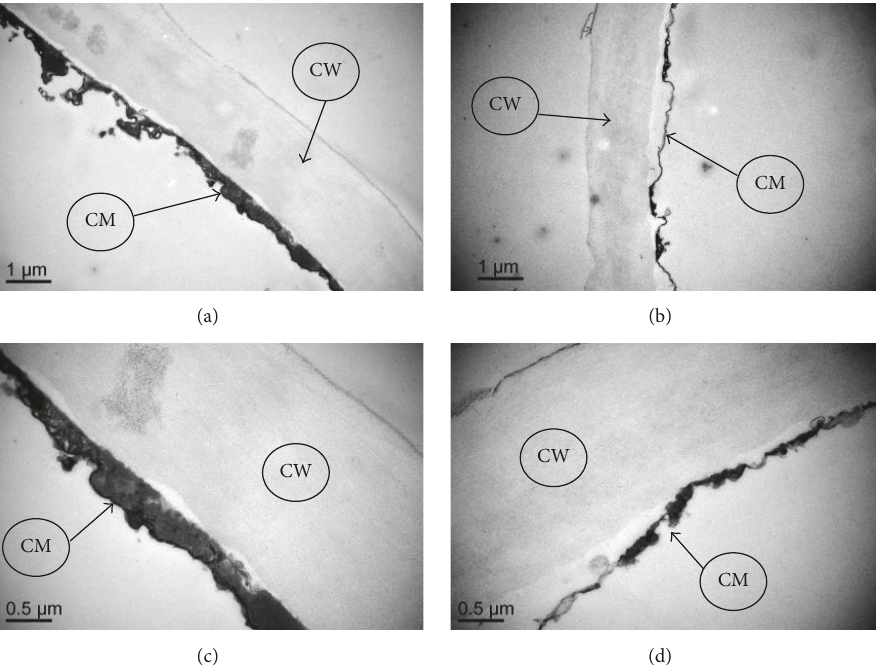
Figure 7: Microphotographs from TEM of cell wall and membrane in apple slices before and after hot-water blanching. (a) Before hot- water blanching at 20000x magnification; (b) after hot-water blanching at 20000x magnification; (c) before hot-water blanching at 40000x magnification; (d) after hot-water blanching at 40000x magnification; CW: cell wall; CM: cell